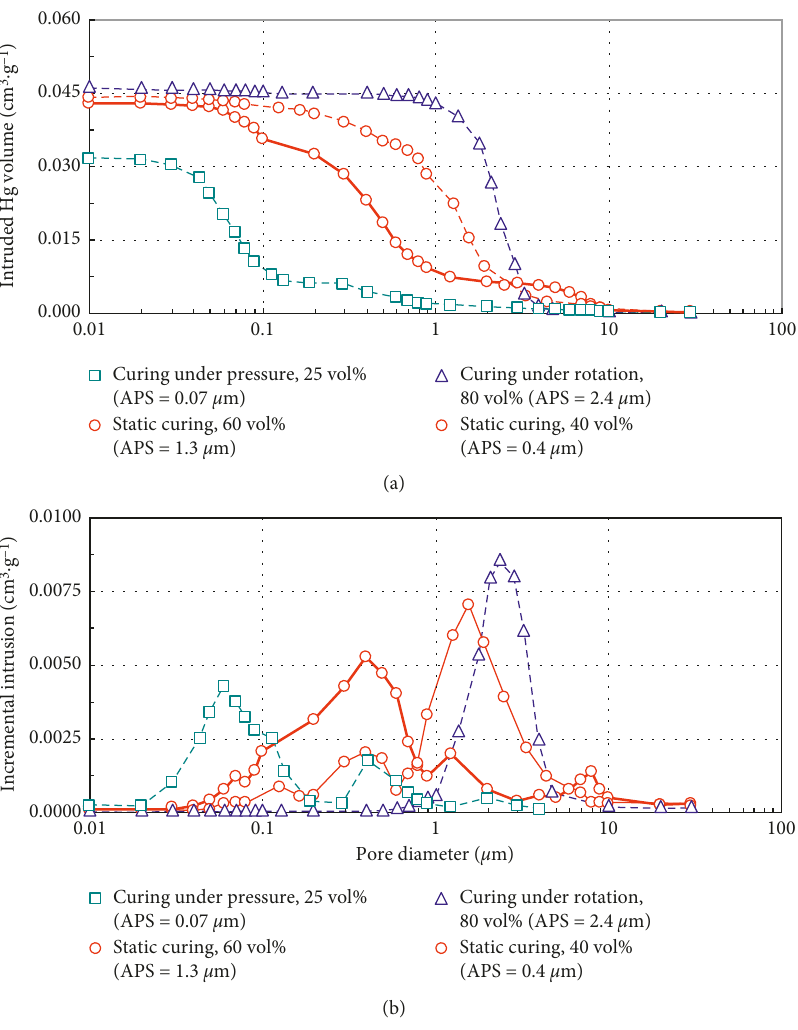
Figure 4: (a) Continuous and (b) incremental pore size distribution for samples mixed and cured in the conventional static way containing 40 vol.% and 60 vol.% of water, containing 80 vol.% of water after curing under rotation, and containing 25 vol.% of water cast under isostatic pressing. APS � average pore size.